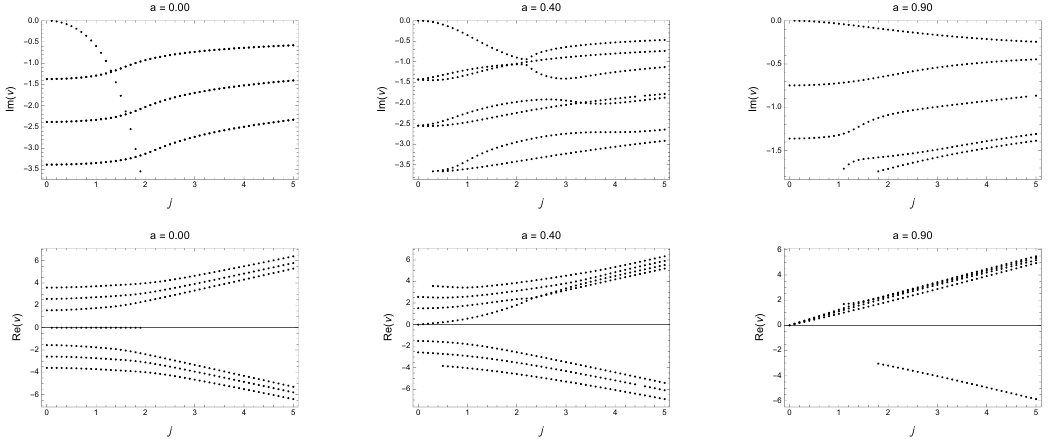
Figure 5 . Vector sector dispersion relations. Displayed here are the real and imaginary parts of quasinormal frequencies of h 3+ and h t + for large black holes in case (ii) as a function of j . Modes displayed here were found with precision of at least d(cid:23) = (cid:23) 10 (cid:0) 5 . Missing modes did not converge to su(cid:14)cient precision and have been (cid:12)ltered out by the numerical routine. For a complementary view, these QNMs are shown in the complex frequency plane in (cid:12)gure 16.